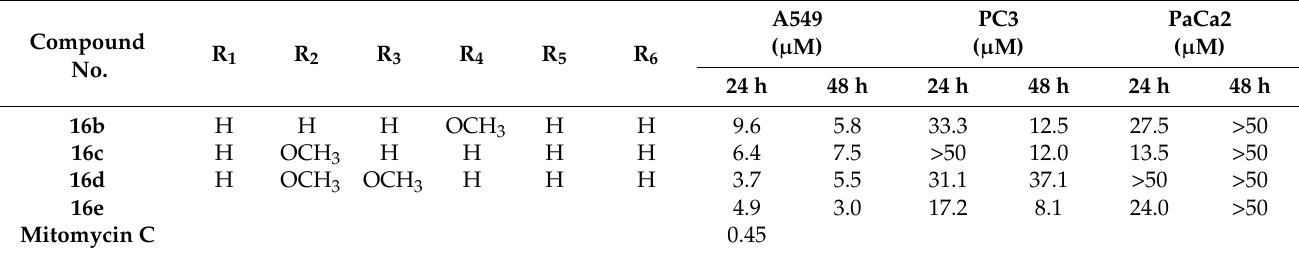
Figure 18. Structure of indole-chalcone based hybrids and the most promising compound 16a . Table 16. In vitro cytotoxic activities of indole-chalcone based hybrid compounds 16 ( b – e ).